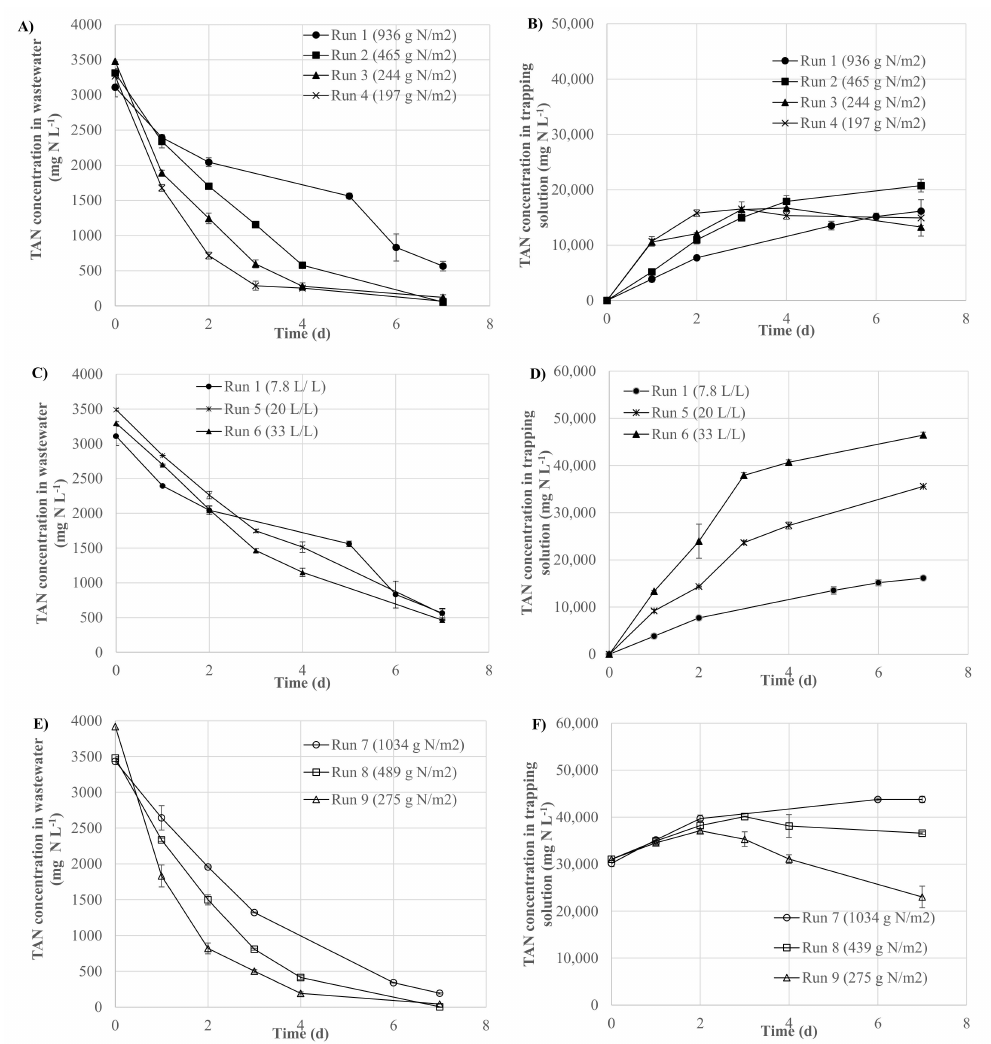
Figure 2. Variation of TAN concentrations in the synthetic wastewater and in the acidic trapping solution for the nine experiments performed: ( A ) Evolution of TAN concentration in wastewater for Runs 1–4; ( B ) Evolution of TAN concentration in the acidic trapping solution in Runs 1–4; ( C ) Evolution of TAN concentration in wastewater for Runs 1, 5 and 6; ( D ) Evolution of TAN concentration in the acidic trapping solution in Runs 1, 5 and 6; ( E ) Evolution of TAN concentration in wastewater for Runs 7–9 and ( F ) Evolution of TAN concentration in the acidic trapping solution in Runs